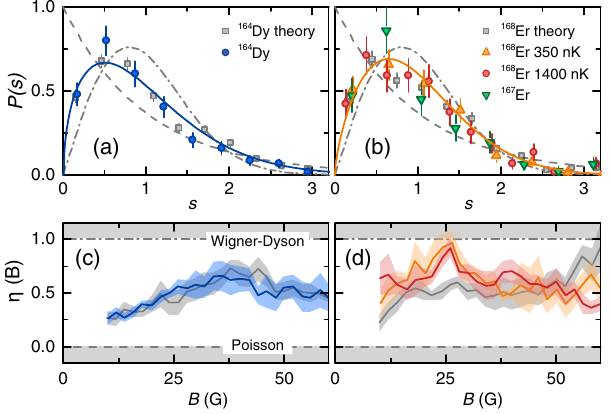
FIG. 2. (a) Nearest-neighbor spacing distribution P ð s Þ deter- mined from all observed Fano-Feshbach resonances for 164 Dy (blue markers). Dashed and dot-dashed curves are the Poisson and Wigner-Dyson distribution, respectively. The solid line is a Brody distribution with η ¼ 0 . 45 ð 7 Þ fit to the experimental data. (b) Distributions P ð s Þ for 168 Er at T ¼ 350 nK and T ¼ 1 . 4 μ K (orange and red markers, respectively), and 167 Er at T ¼ 0 . 4 T F (green markers), where T is the Fermi temperature of the gas. F The solid line is a Brody distribution with η ¼ 0 . 68 ð 9 Þ fit to the 168 Er data at T ¼ 350 nK. Panels (c) and (d) show the magnetic- field-resolved Brody parameter η ð B Þ as a function of magnetic field for 164 Dy and 168 Er, respectively. The Brody parameters for the Poisson and Wigner-Dyson distribution are 0 and 1, respec- tively. Gray markers and lines in all four panels are results from our coupled-channels calculations. The 1 σ error bars in (a) and (b) correspond to Poisson counting errors, while shaded bands in (c) and (d) are 1 σ statistical uncertainties of the fits to the